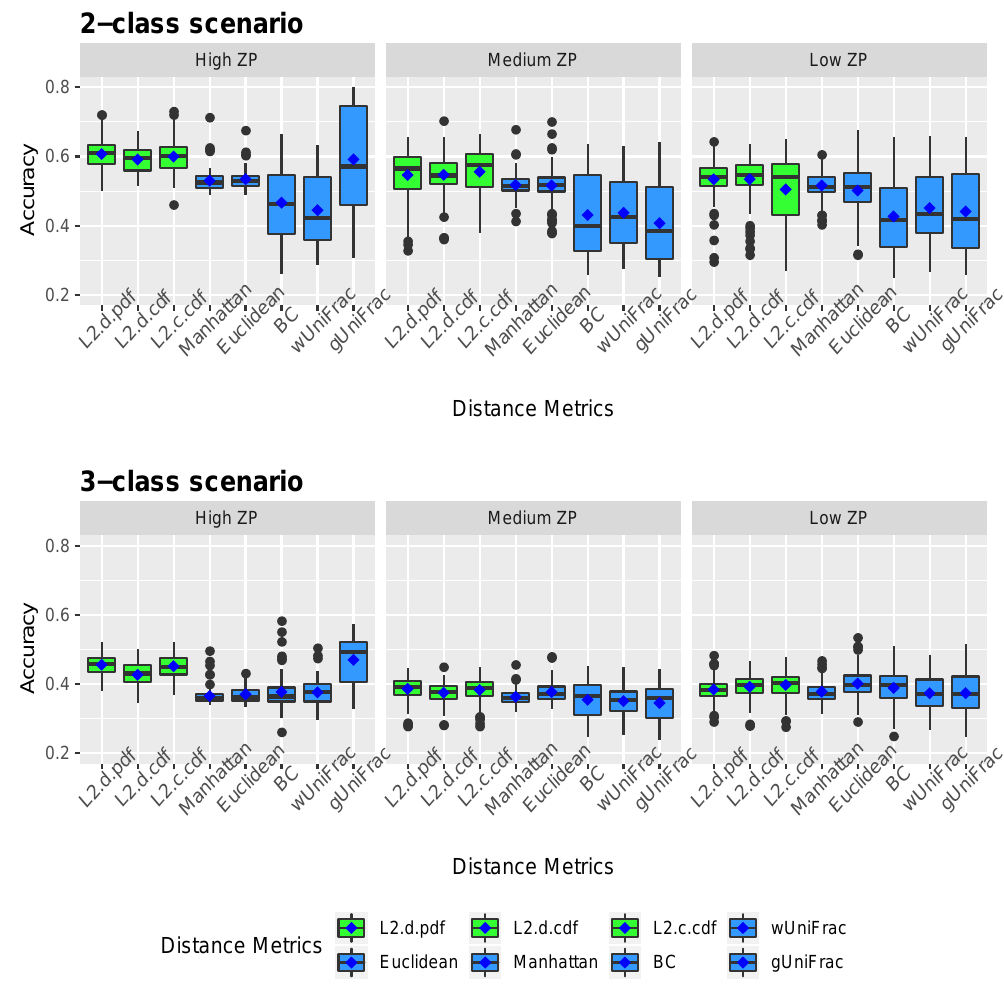
Figure 2. Accuracy boxplots for simulated data. Two-subclass and three-subclass scenarios are considered. Three different cases of proportion of zeros (ZP) are evaluated - high ZP, medium ZP, and low ZP, are presented in left, middle, and right, respectively. For each box of the boxplots, the center line represents the median, the two vertical lines represent the 25th percentiles to the 75th percentiles. The whiskers of the boxplots show 1.5 interquartile range (IQR) below the 25th percentiles and 1.5 IQR above the 75th percentiles. The mean are shown in blue diamond